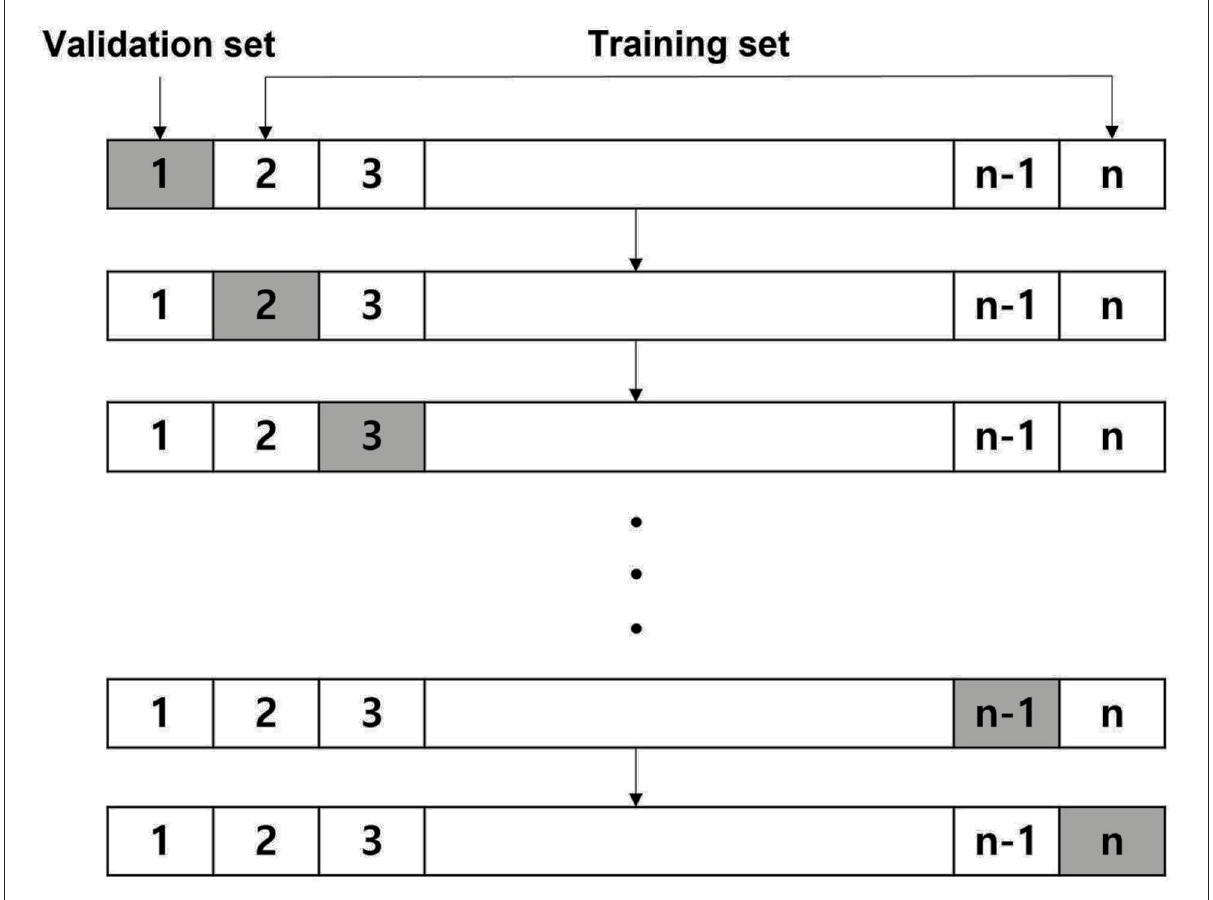
FIGURE1 Leave-one-out